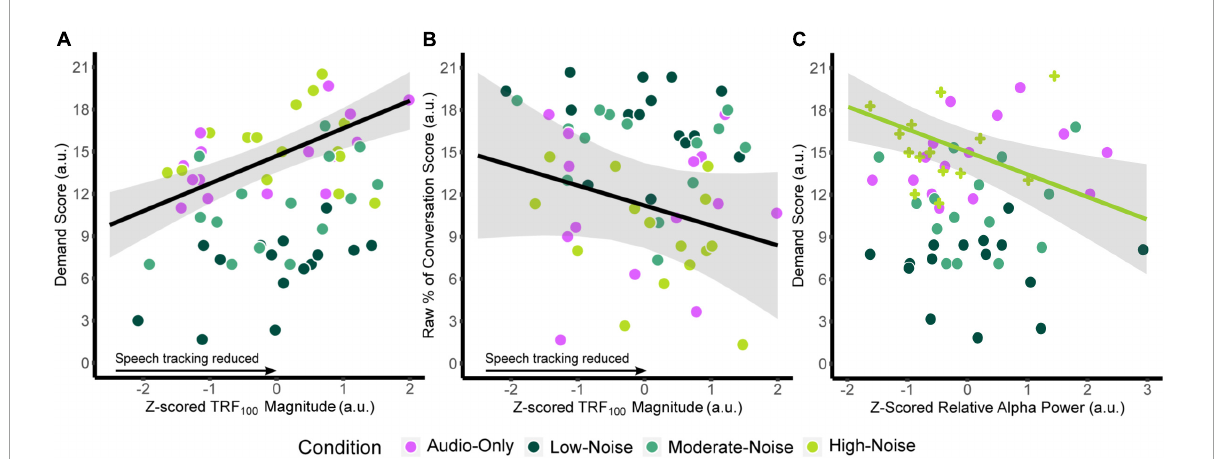
FIGURE7 Plots of the function between (A) z-scored TRF 100 amplitude and listening demand ratings, (B) z-scored TRF 100 amplitude and the perceived percentage of conversation understood. The black line indicates the regression line, bounded by the 95% confidence intervals indicated in the shaded gray region, both for visualization purposes. (C) Plots z-scored relative alpha power and listening demand ratings in the High-Noise condition. The green line indicates the regression line of the High-Noise condition bounded by the 95% confidence intervals indicated in the shaded gray region for visualization purposes. The plus symbols indicate relative alpha power in the High-Noise